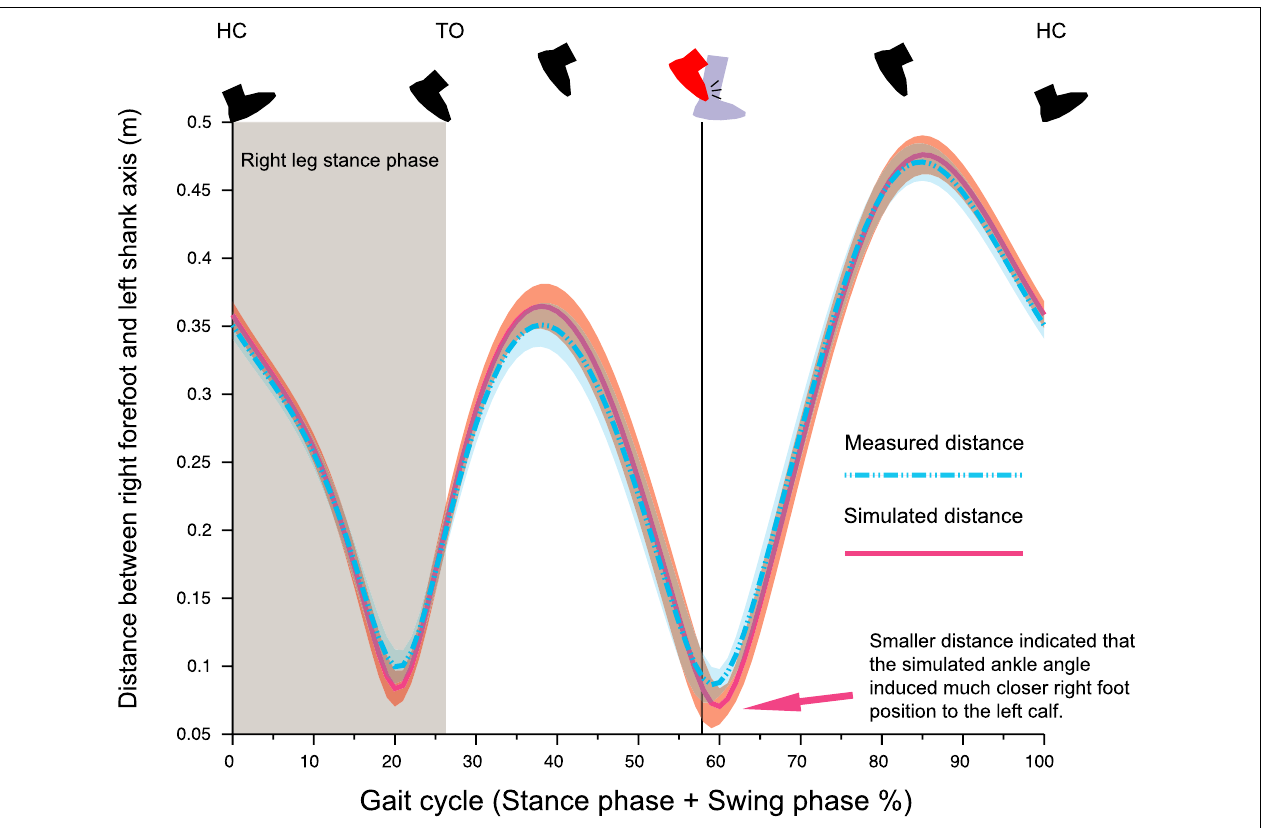
FIGURE 5 | Temporal pattern of the distance between right forefoot (marker FBC) to the left shank segment. If the right ankle was adducted by 7 ◦ and plantarflexed by 10 ◦ from the observed ankle position as that of left ankle, the distance between right foot and left shank was much closer (Arrow), suggesting the right ankle position observed in this trial was a collision-avoiding